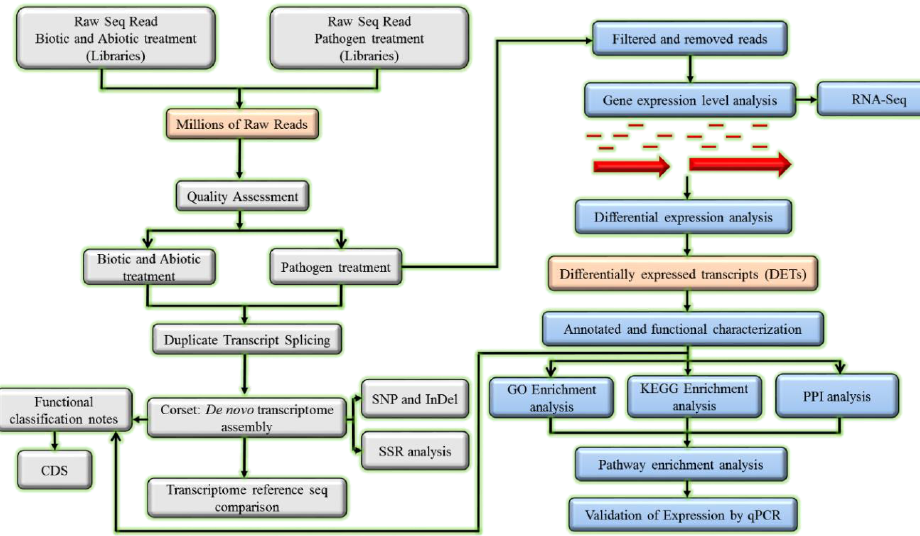
Figure 2. A workflow sketch of sugarcane transcriptome analysis including construction of reference transcriptomefromthedenovo assemblyandannotationandfunctional characterization ofdi ff erentially expressed transcripts